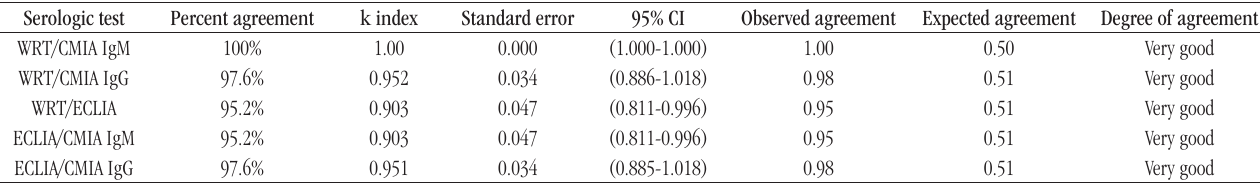
TABLE 2 – Agreement between four serological tests in the evaluation of control group